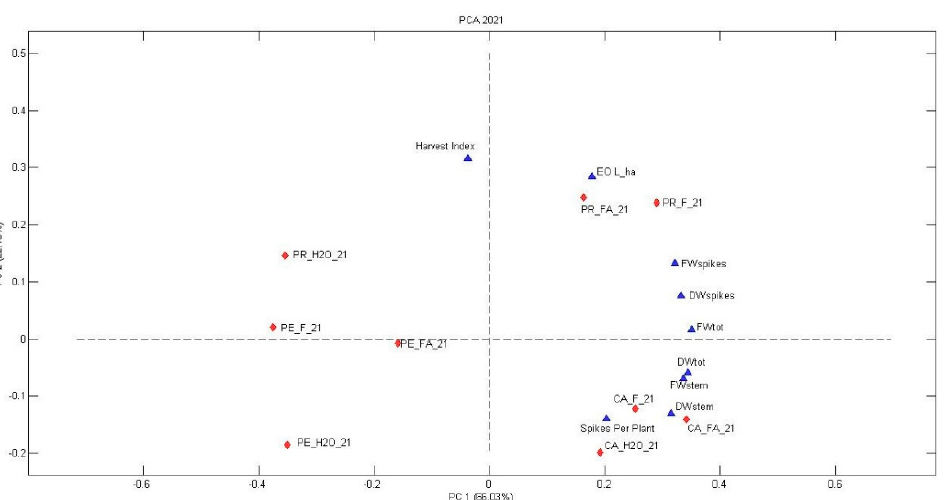
Figure 3. Principal component analysis (PCA) biplot of the morphological data from 2020/2021. CA, Campazzo; PE, Pedroni; PR, Preci; H2O, control with foliar application of tap water; F, foliar application of FITOSTIM; FA, foliar application of FITOSTIM ALGA; DW, dry weight; FW, fresh weight; EO L_ha, yield of essential oils (L ha —1 ).